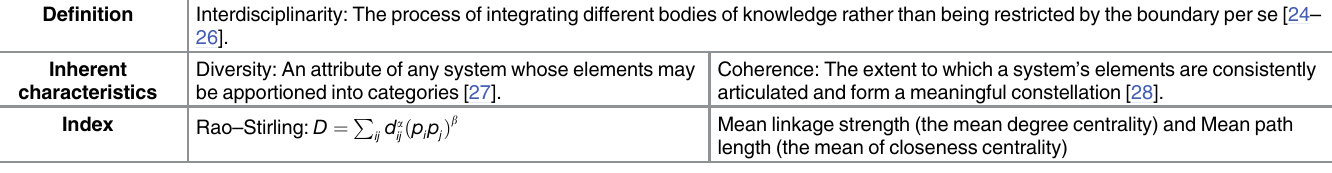
Table 1. Definition, Inherent Characteristics, and Indexes of Interdisciplinarity. De fi nition Interdisciplinarity: The process of integrating different bodies of knowledge rather than being restricted by the boundary per se [24 – 26]. Inherent